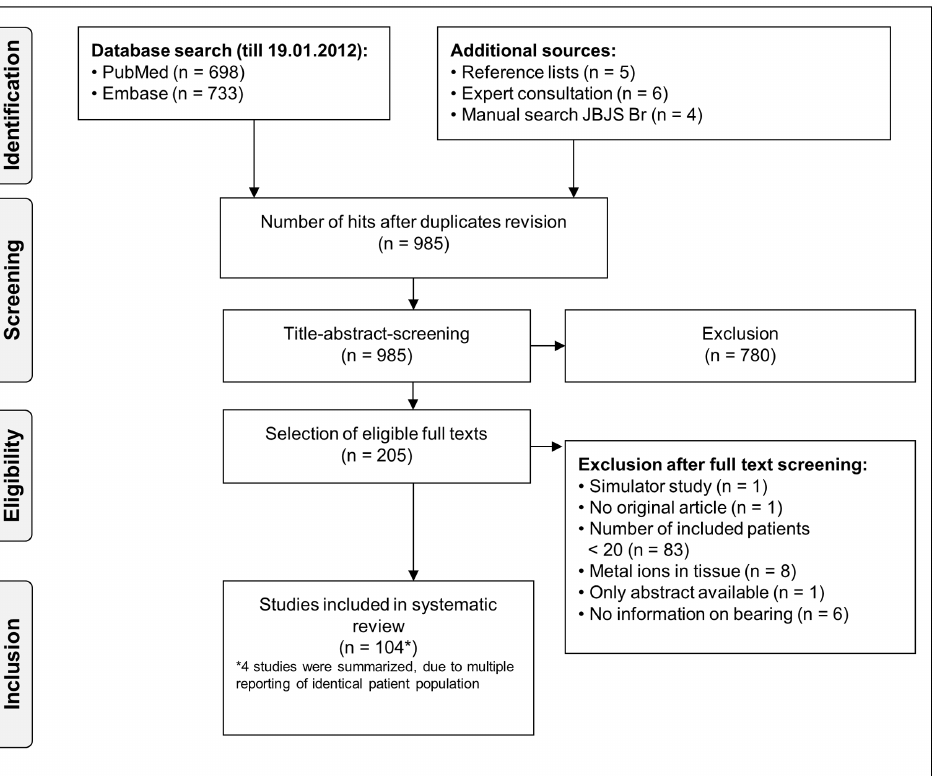
Figure 1. Study flow chart of in- and excluded studies. Figure 1 summarizes the yield of systematic search and study selection [31]. Overall, 104 studies (11 RCTs, 14 cohort studies, 1 case-control study, 55 cross-sectional studies, 2 case series) were identified and